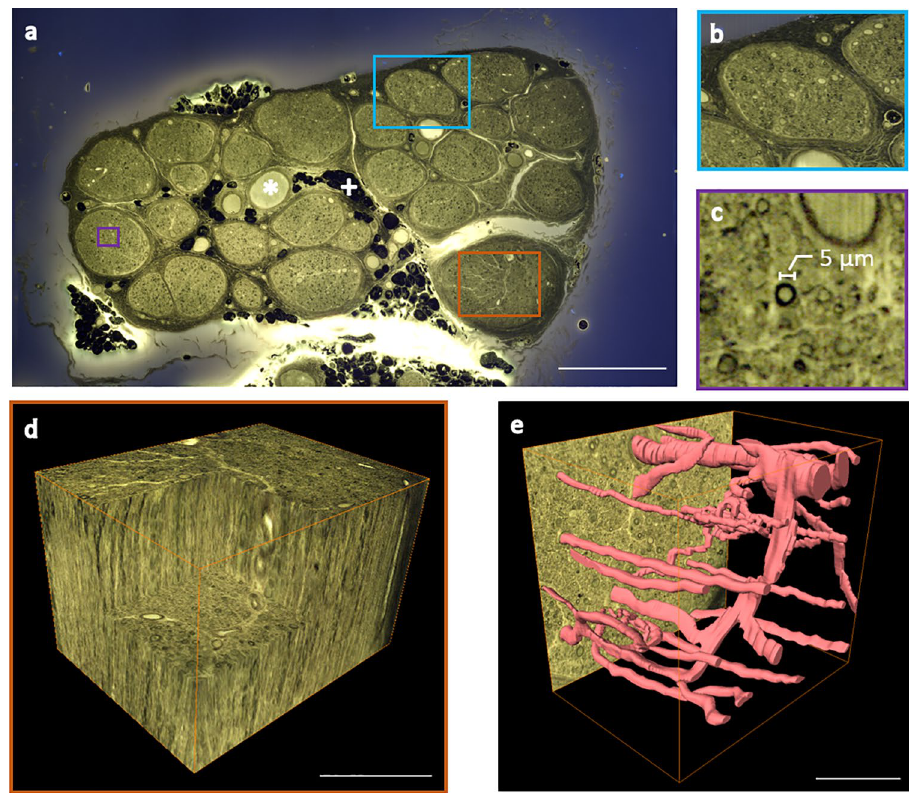
Figure 4. Imaging a cadaver tibial nerve sample with block-face 3D-MUSE imaging. The nerve was post- fixed with osmium tetroxide and counterstained with rhodamine B. Images were acquired with a 10 × 0.45 NA objective and the sample was sectioned at 5 µm thickness. Further details of the system are provided in “Methods”. ( a ) Representative block face image stitched from twelve individual tiles. Structures of interest include fascicles, venuole (asterisk), and adipose cells (plus). ( b and c ) Close up views indicate individual fascicles and myelinated fibers respectively. ( d ) Volume rendering of a region within a fascicle, outlined by